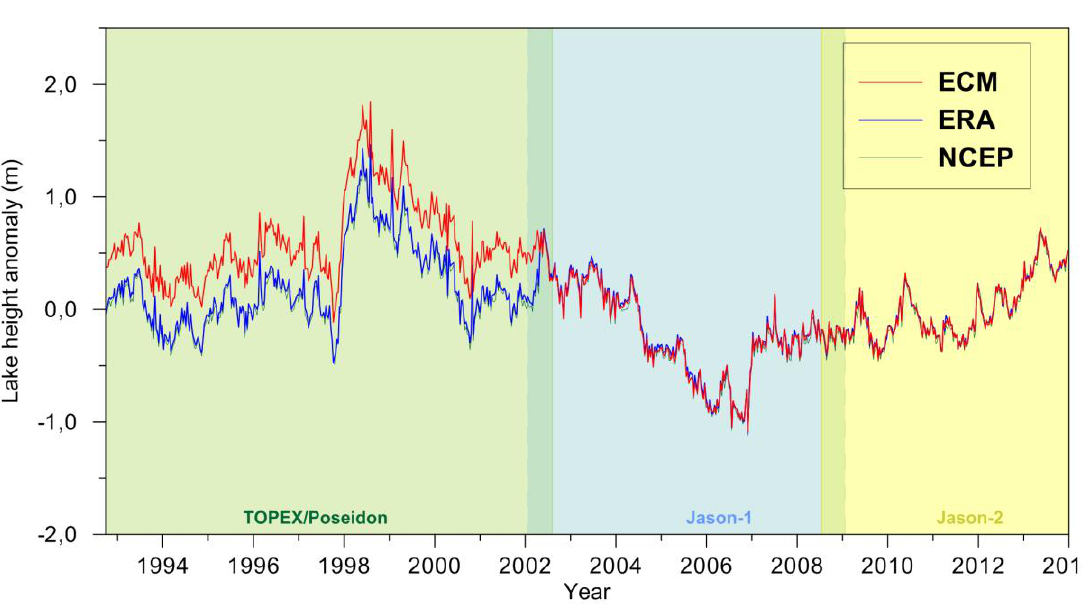
Figure 14. Median water level anomalies (m) for Lake Victoria, Africa, derived using tropospheric (dry + wet) corrections from three models, for each cycle of T/P Phase A, Jason-1 Phase A and Jason-2. Water level heights are with respect to the EGM2008 geoid. A mean lake height of 1135 m has been removed.